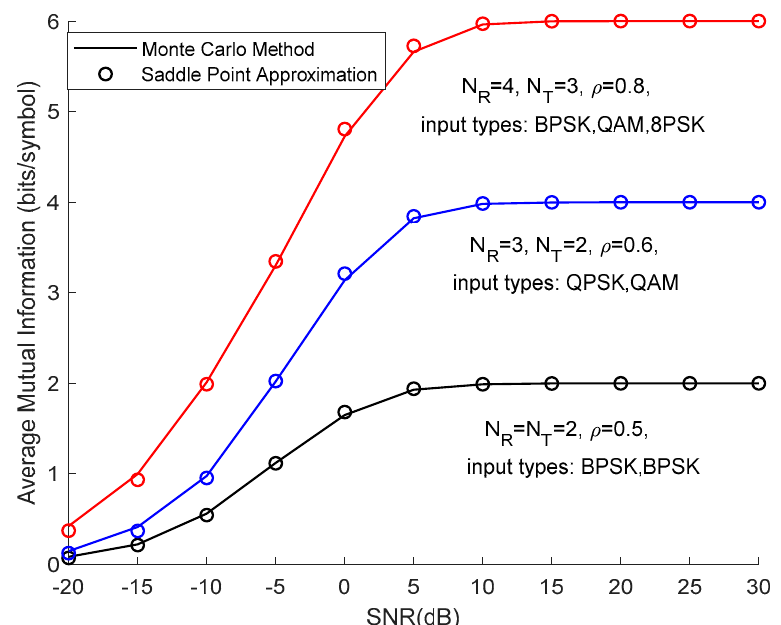
Figure 2. Comparison on MI calculated by Monte Carlo and saddle point approximation under different input types and correction parameters ( ρ T = ρ R = ρ ) over doubly correlated Rice fading channel model.